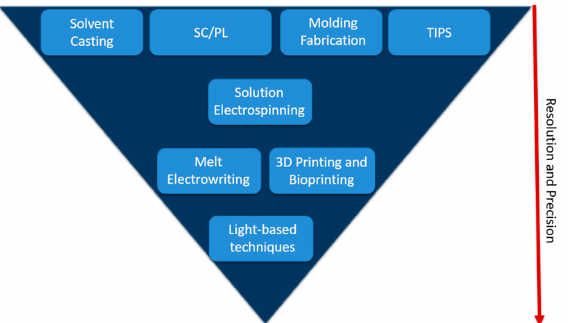
Figure 2. Overview of fabrication methods used for retinal tissue engineering. SC/PL stands for solvent casting-particulate leaching and TIPS for thermally induced phase separation. The red arrow indicates the increase in precision and resolution of the techniques.